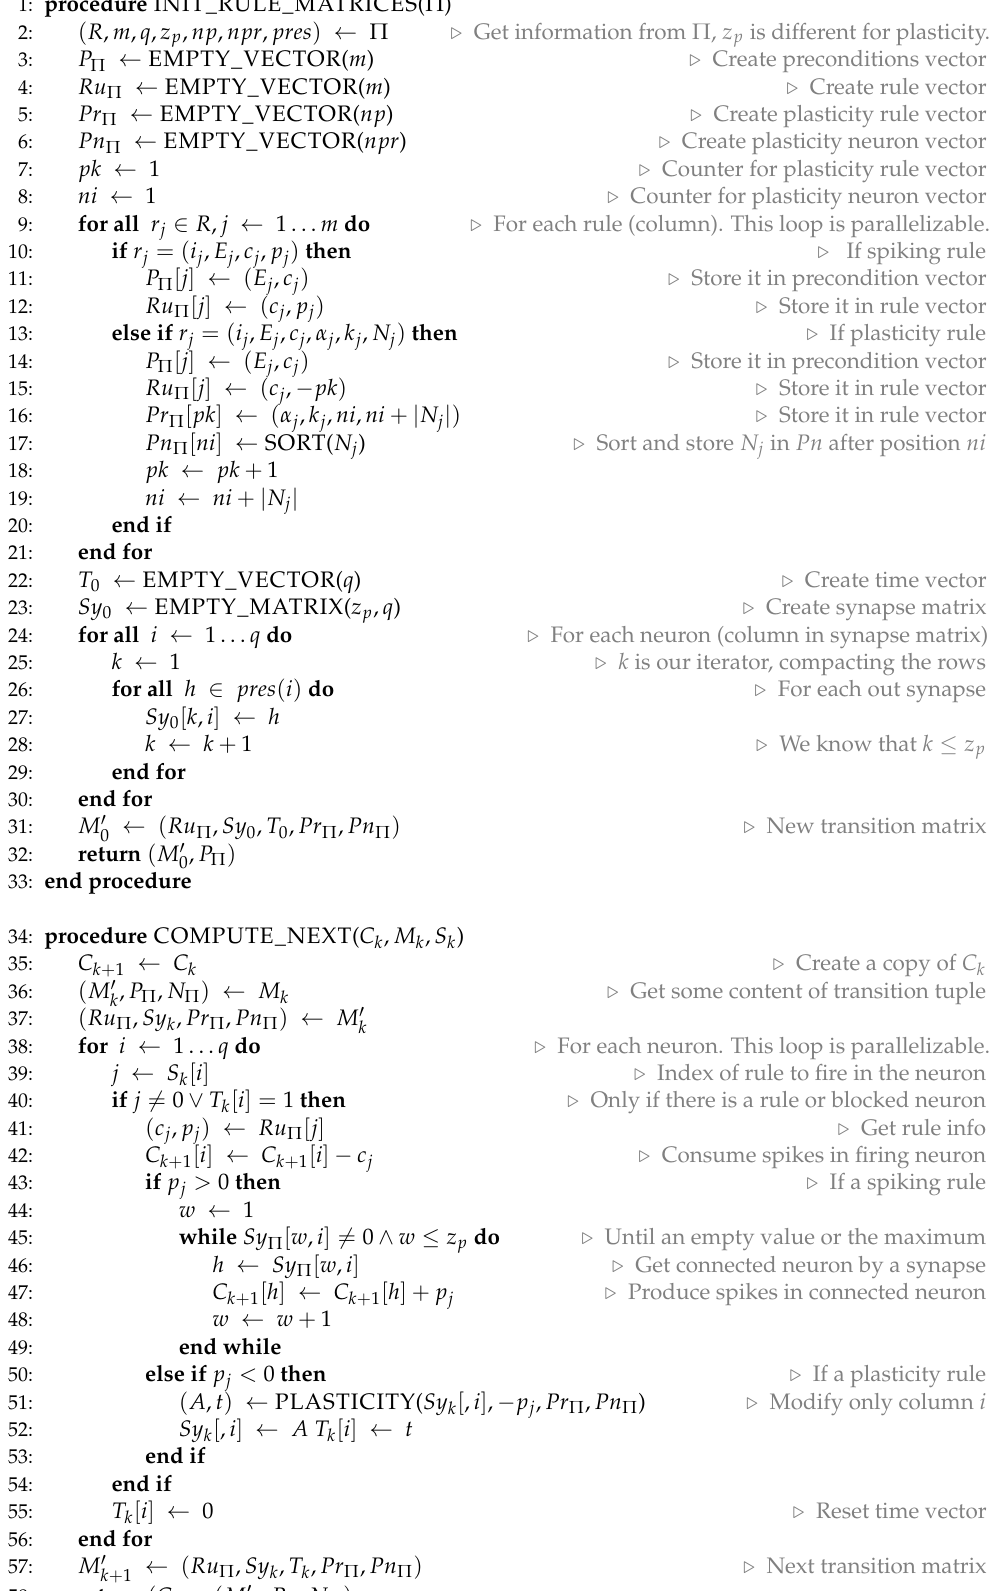
Algorithm 10 Functions for dynamic SNP systems with plasticity rules using optimized compressed matrix